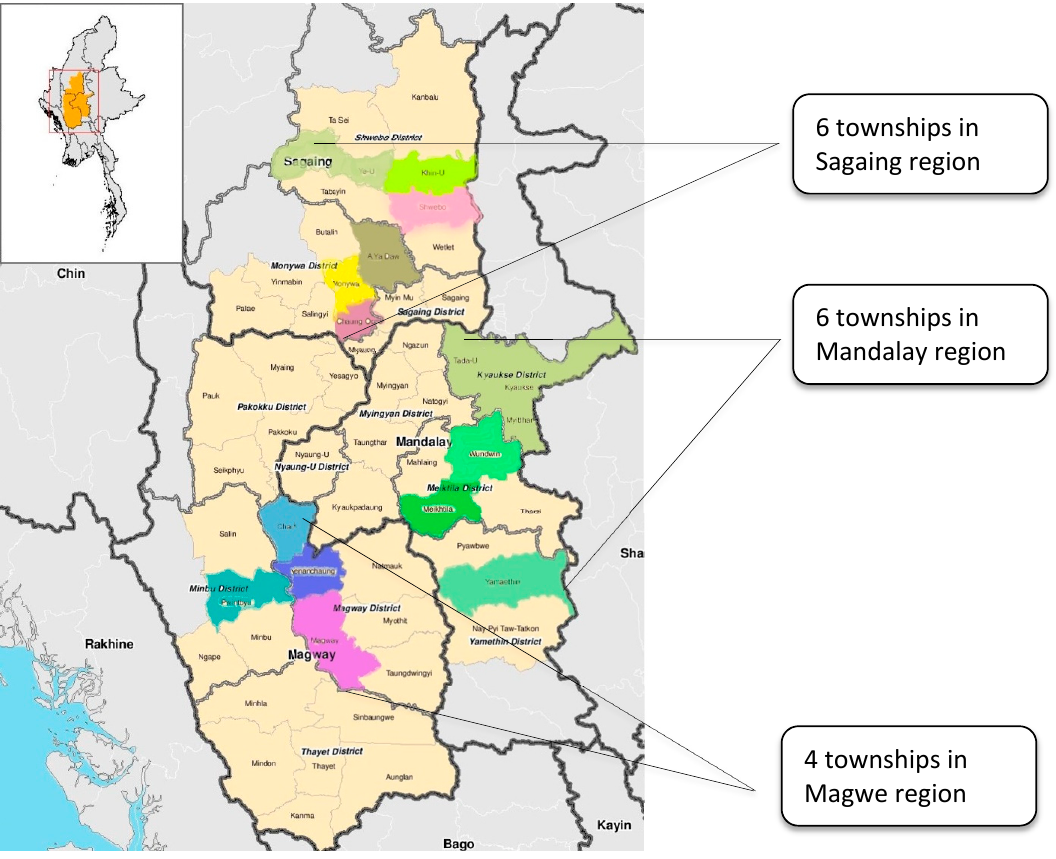
Figure 1. Map of the Dry Zone region in Central Myanmar (Source: Myanmar Information Management Unit).